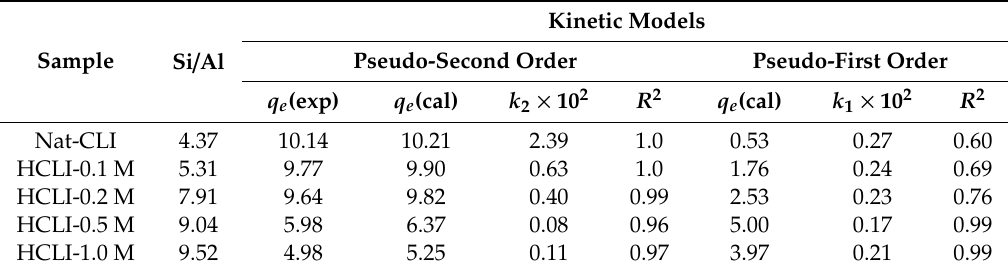
Table 2. Kinetic parameters for Pb(II) sorption by non- and acid-modified clinoptilolite-rich tu ff s obtained by applying the pseudo-second order and pseudo-first order models.